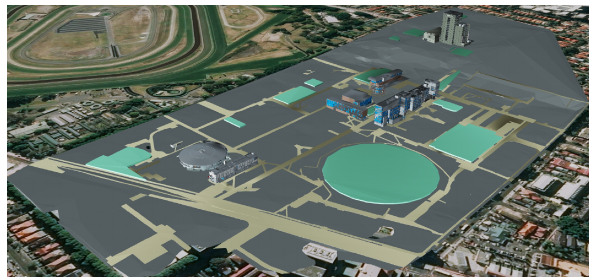
Figure 7. Visualisation of several BIM models, roads and green areas in Cesium.